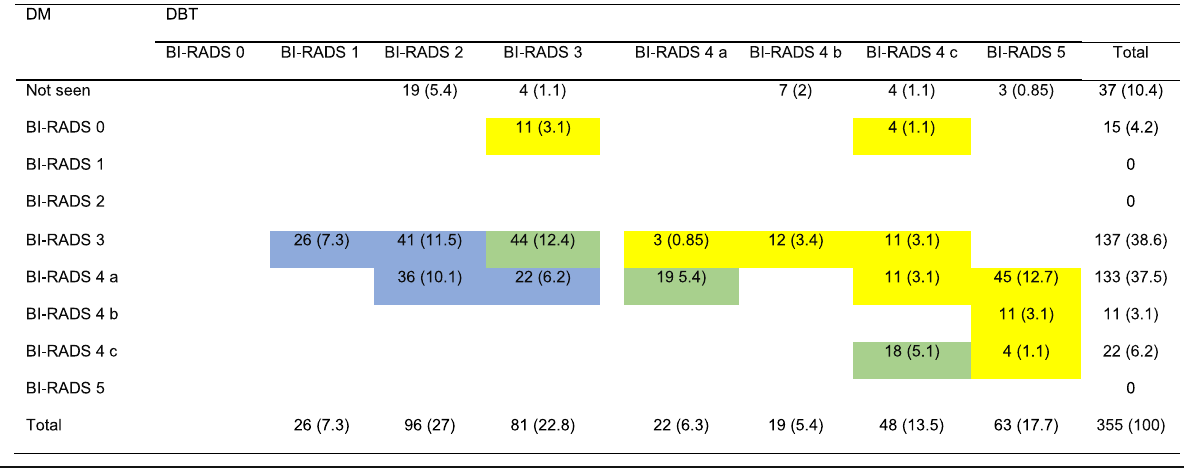
The data are represented as numbers with the corresponding percentages given in parentheses The different colors indicate whether DBT upgraded (yellow), downgraded (blue), or kept the grade the same (green) as DM